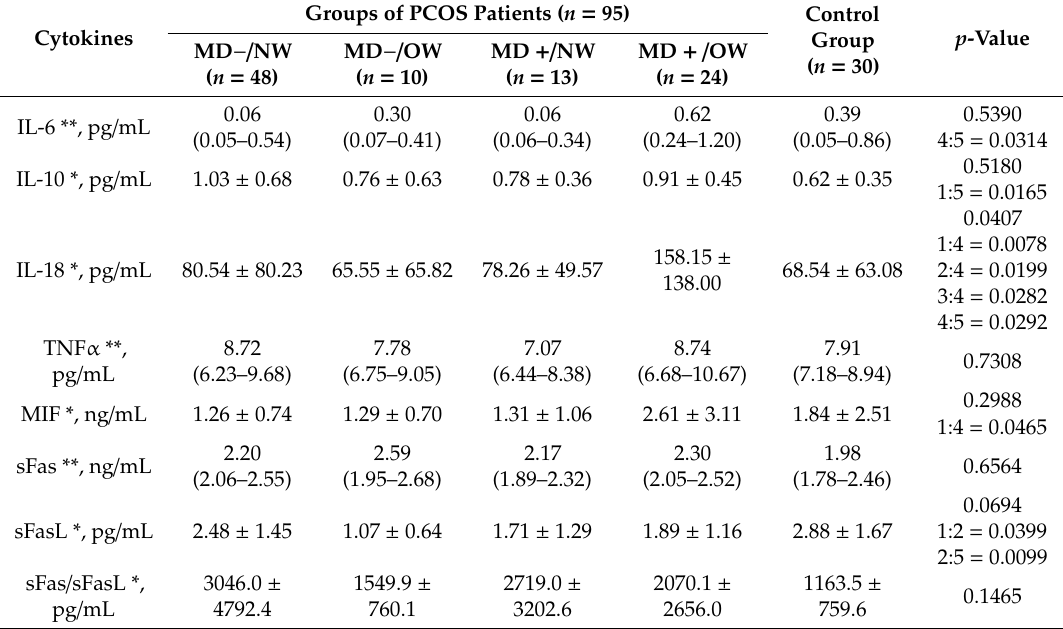
Table 3. Cytokine profile of peripheral blood in adolescent girls with PCOS, grouped by BMI and presence of